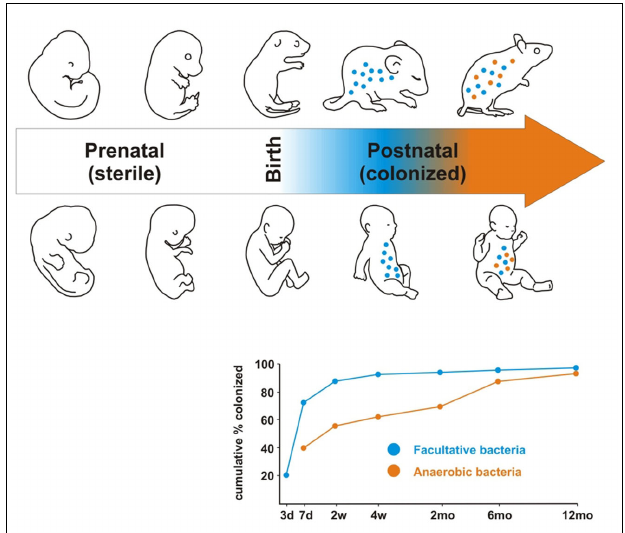
FIGURE 1 | Development of the microbiome in early life. Subsequent to the sterile uterine environment, colonization begins at birth with facultative bacteria (blue) colonizing the GIT immediately.The anaerobic bacteria colonize later (orange). By 1year of age the microbiome has a stable adult-like signature. Rodents follow a similar colonization pattern to humans and this forms the rationale for the use of germ free animals to study the impact of the